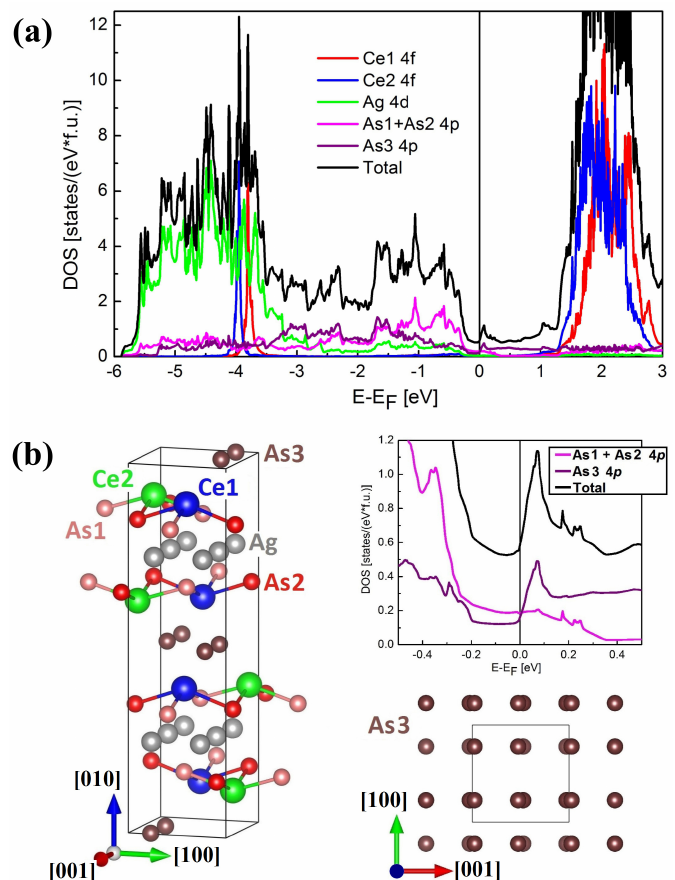
Figure 15. ( a ) Total and partial electronic densities of states calculated for CeAgAs 2 in the LSDA+U (U = 6 eV) approach with the AFM ordering along the [100] axis. ( b ) Left panel: unit cell of CeAgAs 2 ; right panel: enlarged DOS (density of states) in the vicinity of E F and the sketch of quasi-2D nets of the As atoms (As3 sites) with visible distortion from the ideal square-like shape. The structural figures were obtained using the VESTA program